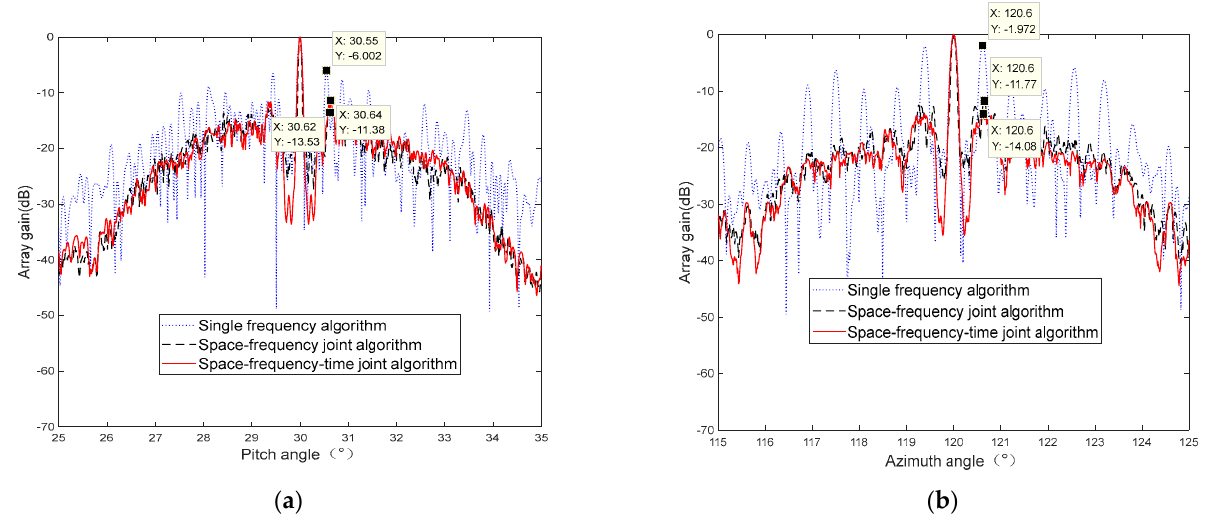
Figure 9. The beampattern under elevation angle of 60 and azimuth angle of 120. ( a ) The elevation pattern; ( b ) the azimuth pattern.